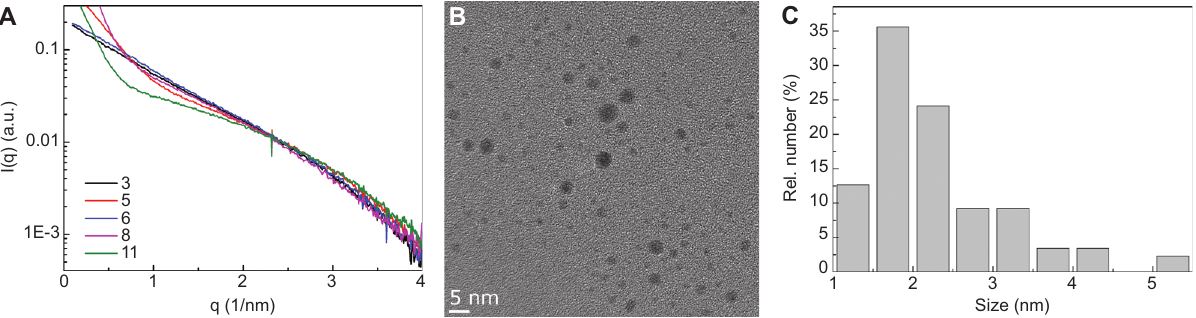
Figure 2 (A) Scattering curves of the different sets of PVP-stabilized 20% Au/Pd NPs. (B) TEM image of a 20% Au/Pd NP sample. Scale bar is 5 nm. (C) Size distribution derived from